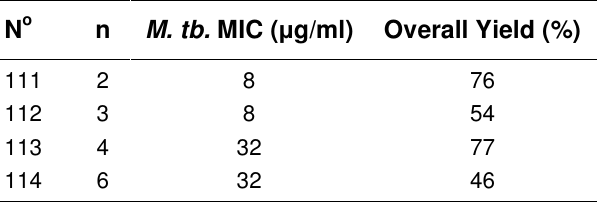
MIC Values of Compounds 111–114 against M.